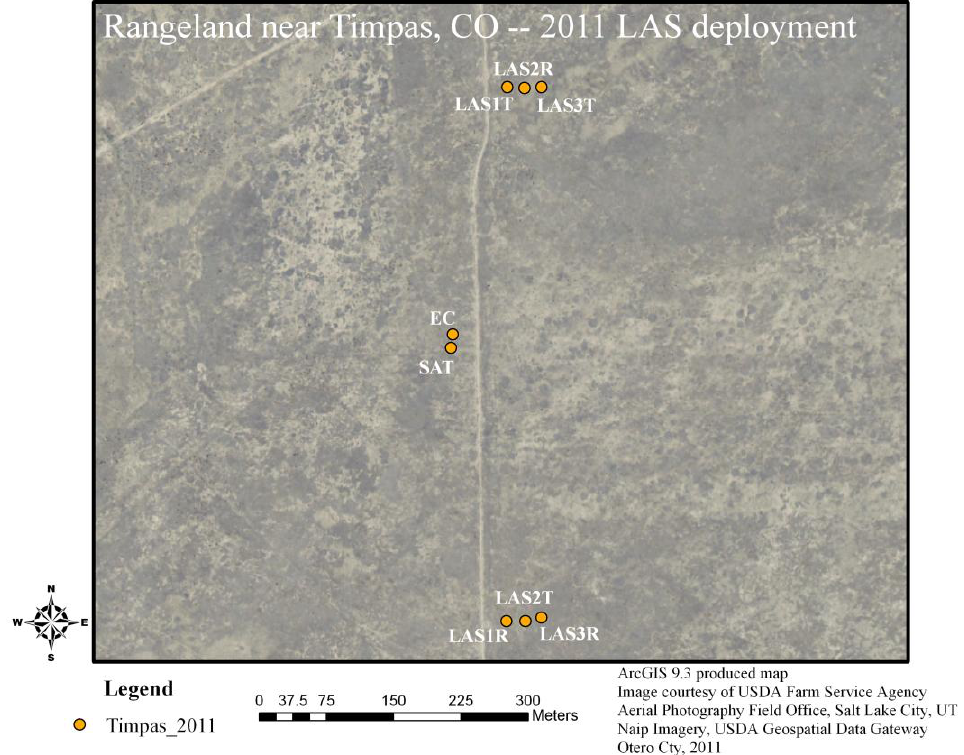
Figure 1. Aerial image overview of the Timpas grassland site. An access (dirt) road ran parallel to the LAS paths, in between the LAS units and the EC and SAT towers. LAS#T represents LAS transmitter and LAS#R represents LAS receiver.